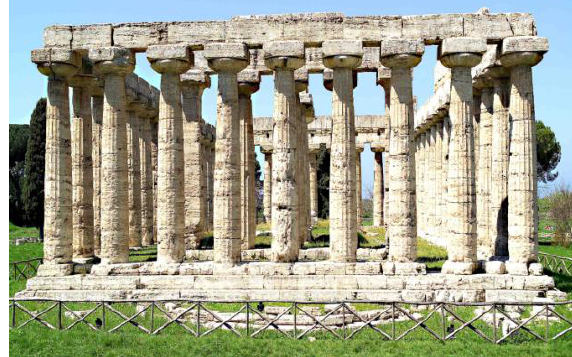
Figure 8. Hera Argiva’s Temple in